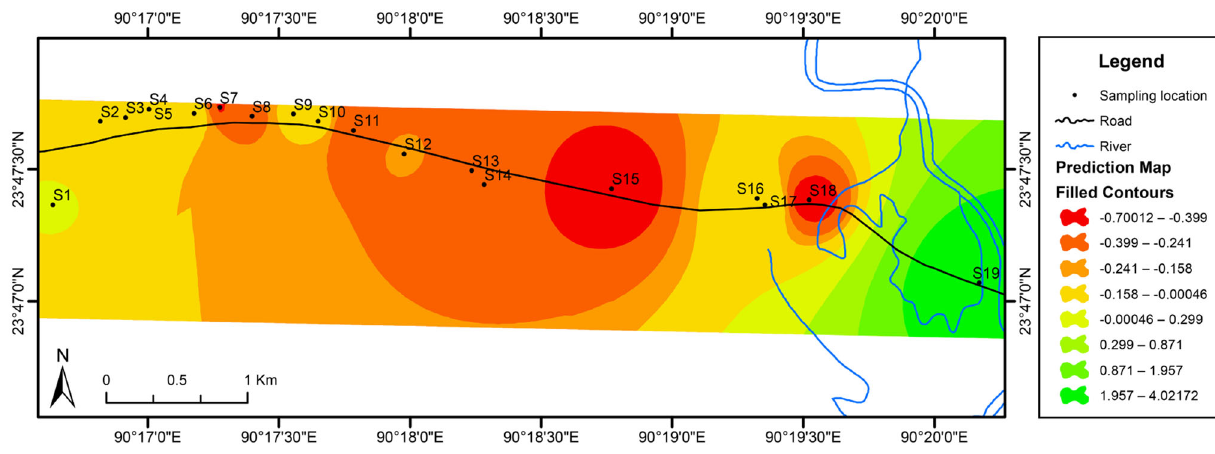
Fig. 7 Factor score map of principle component (PC4)